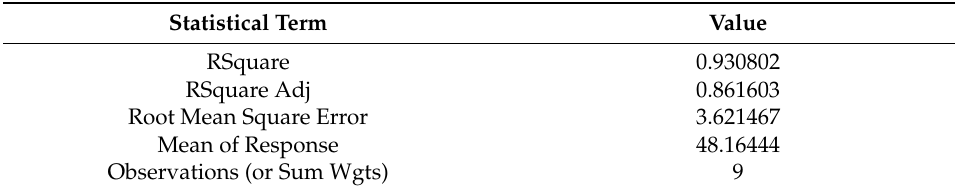
Table 7. Summary of fit (Na-based liquid).